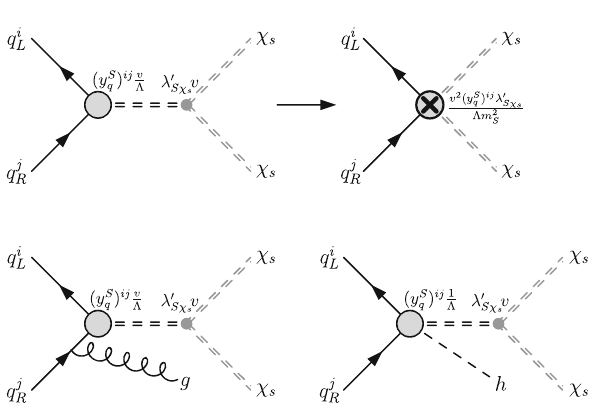
Fig. 12 Relevant diagrams contributing to nuclear interaction with scalar DM (first row) and corresponding DM observables at hadron colliders (monojet and Higgs + / E T , second row), turning on the inter- actions ∼ ( y S q ) ij and ∼ λ (cid:3) S χ s